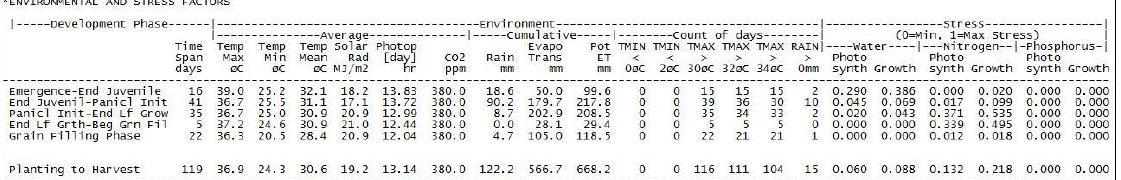
Table 5 : Distribution of important weather parameters under early to medium sowing conditions